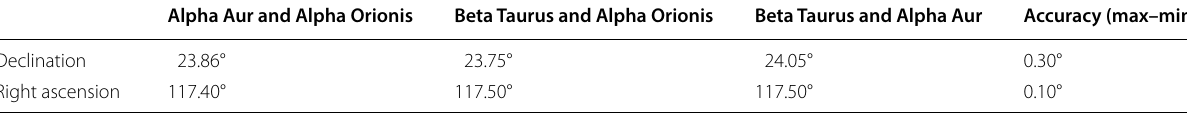
Table 5 Spin axis determination results and accuracy of the small star scanner (SSC)